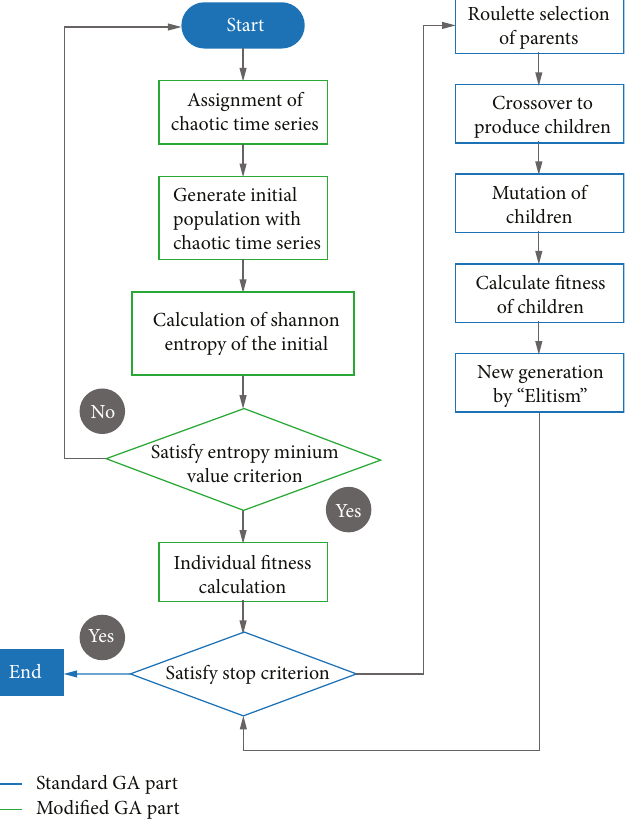
Figure 2: Flowchart of the proposed GA algorithm.